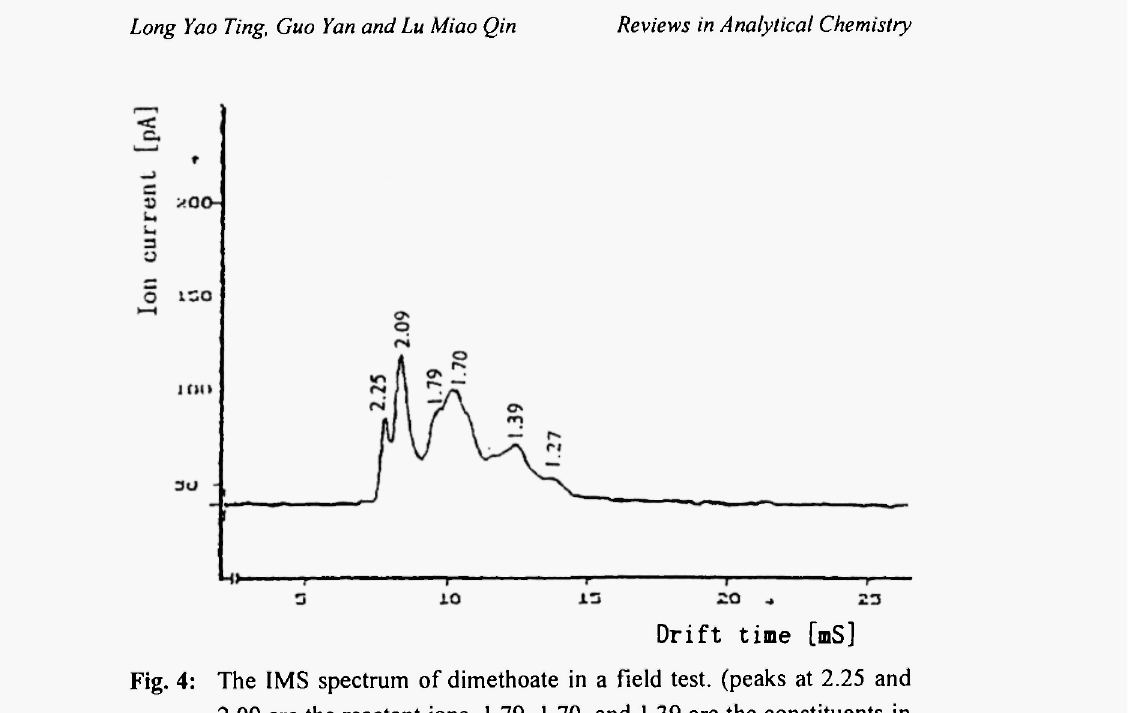
Fig. 4: The IMS spectrum of dimethoate in a Field test, (peaks at 2.25 and 2.09 are the reactant ions, 1.79, 1.70, and 1.39 are the constituents in dimethoate, and 1.27 is the dimer ion of